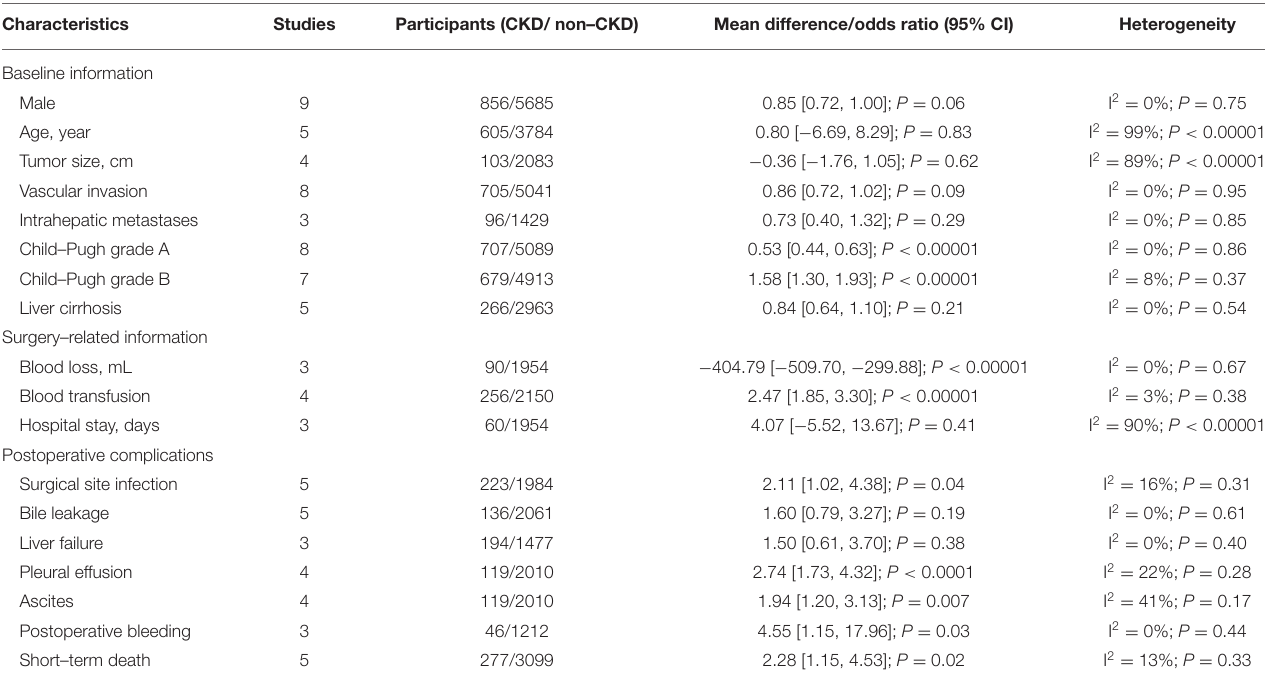
TABLE 2 | Summary of characteristics between CKD group and Non–CKD group.